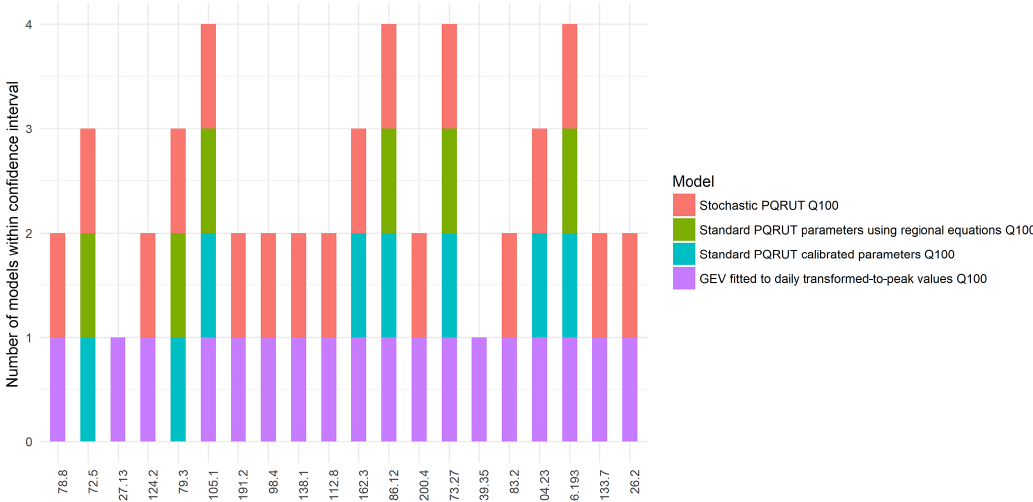
Figure 10. Number of models giving estimates for Q 100 within the confidence intervals of the GP distribution fitted to 1h streamflow